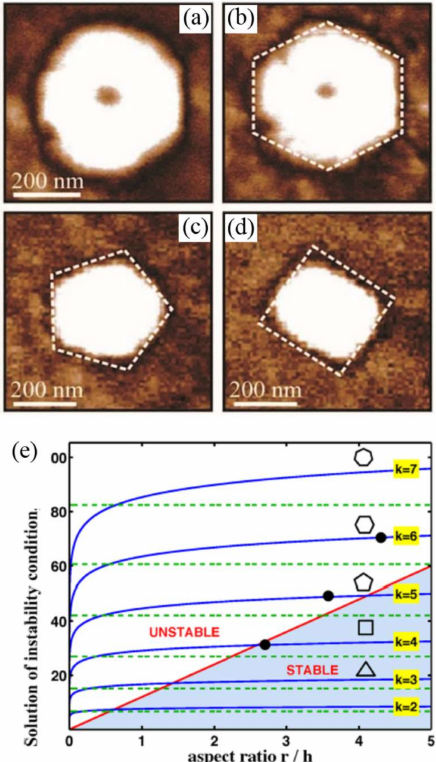
Figure 11. ( a – d ) Rectangular, pentagonal, and hexagonal domain faceting in a ferroelectric with only twofold lattice symmetry (Lukyanchuk et al. [45]). ( e ) Sides of polygonal faceting versus aspect ratio for a thin ferroelectric film [45]. This kind of faceting rearrangement is driven by strain, not thermal fluctuations, and hence does not vanish at T = 0.